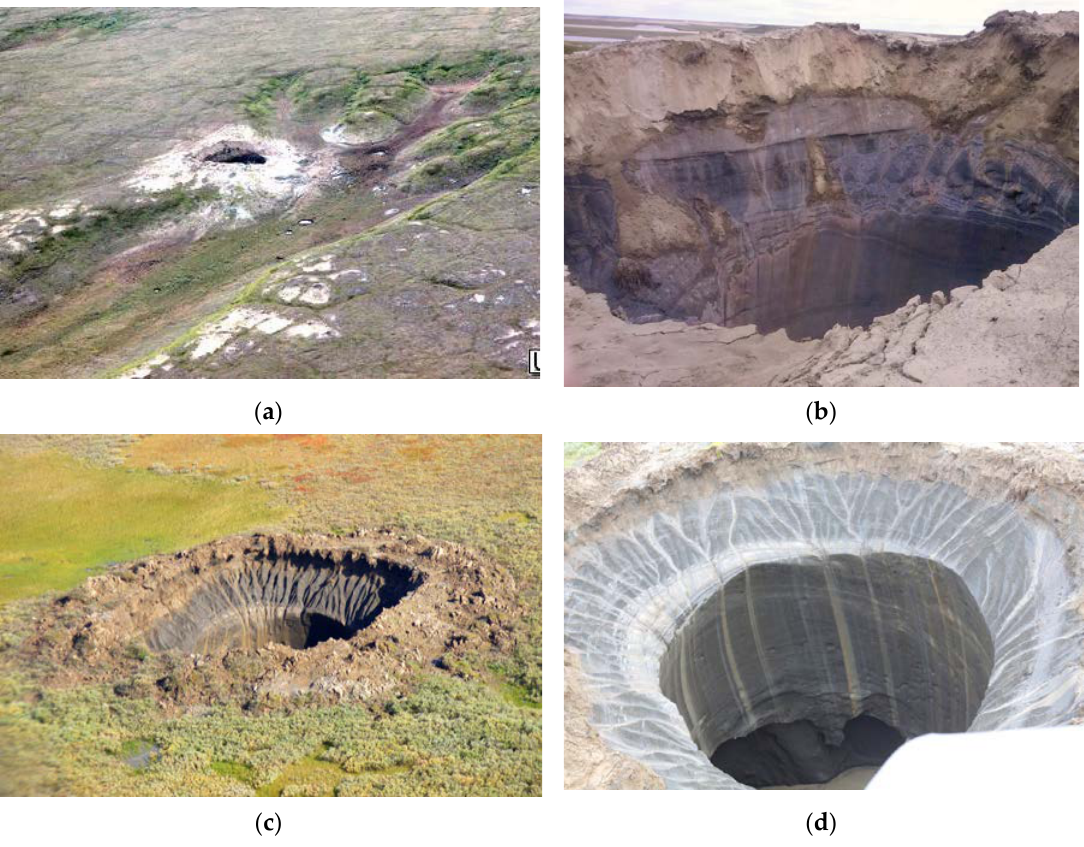
Figure 2. AntGEC and GEC-1 state in summer 2014: ( a ) AntGEC photo taken from a helicopter, the round-shaped crater is located on the terrace edge [26]; ( b ) note the tabular ground ice in AntGEC funnel and cylinder walls, Photo courtesy of Kh. S. Okotetto. ( c ) GEC-1 at a practically flat surface, the foot of a gentle slope. The crater is surrounded by parapet built out of the ejected material. Photo by M. O. Leibman. ( d ) Note the tabular ground ice in GEC-1 funnel and cylinder walls. One can see a grotto in the cylindrical portion. Photo courtesy of V. Pushkarev.